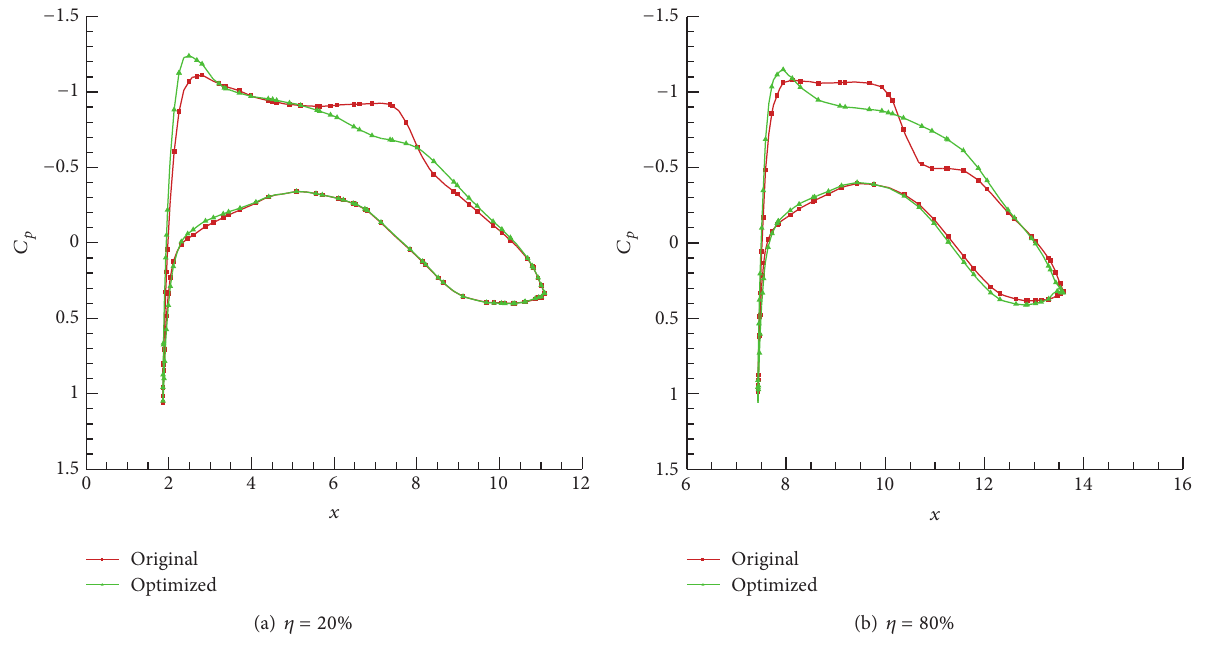
Figure 10: Comparison of section pressure coefficients before and after design of rigid wing.